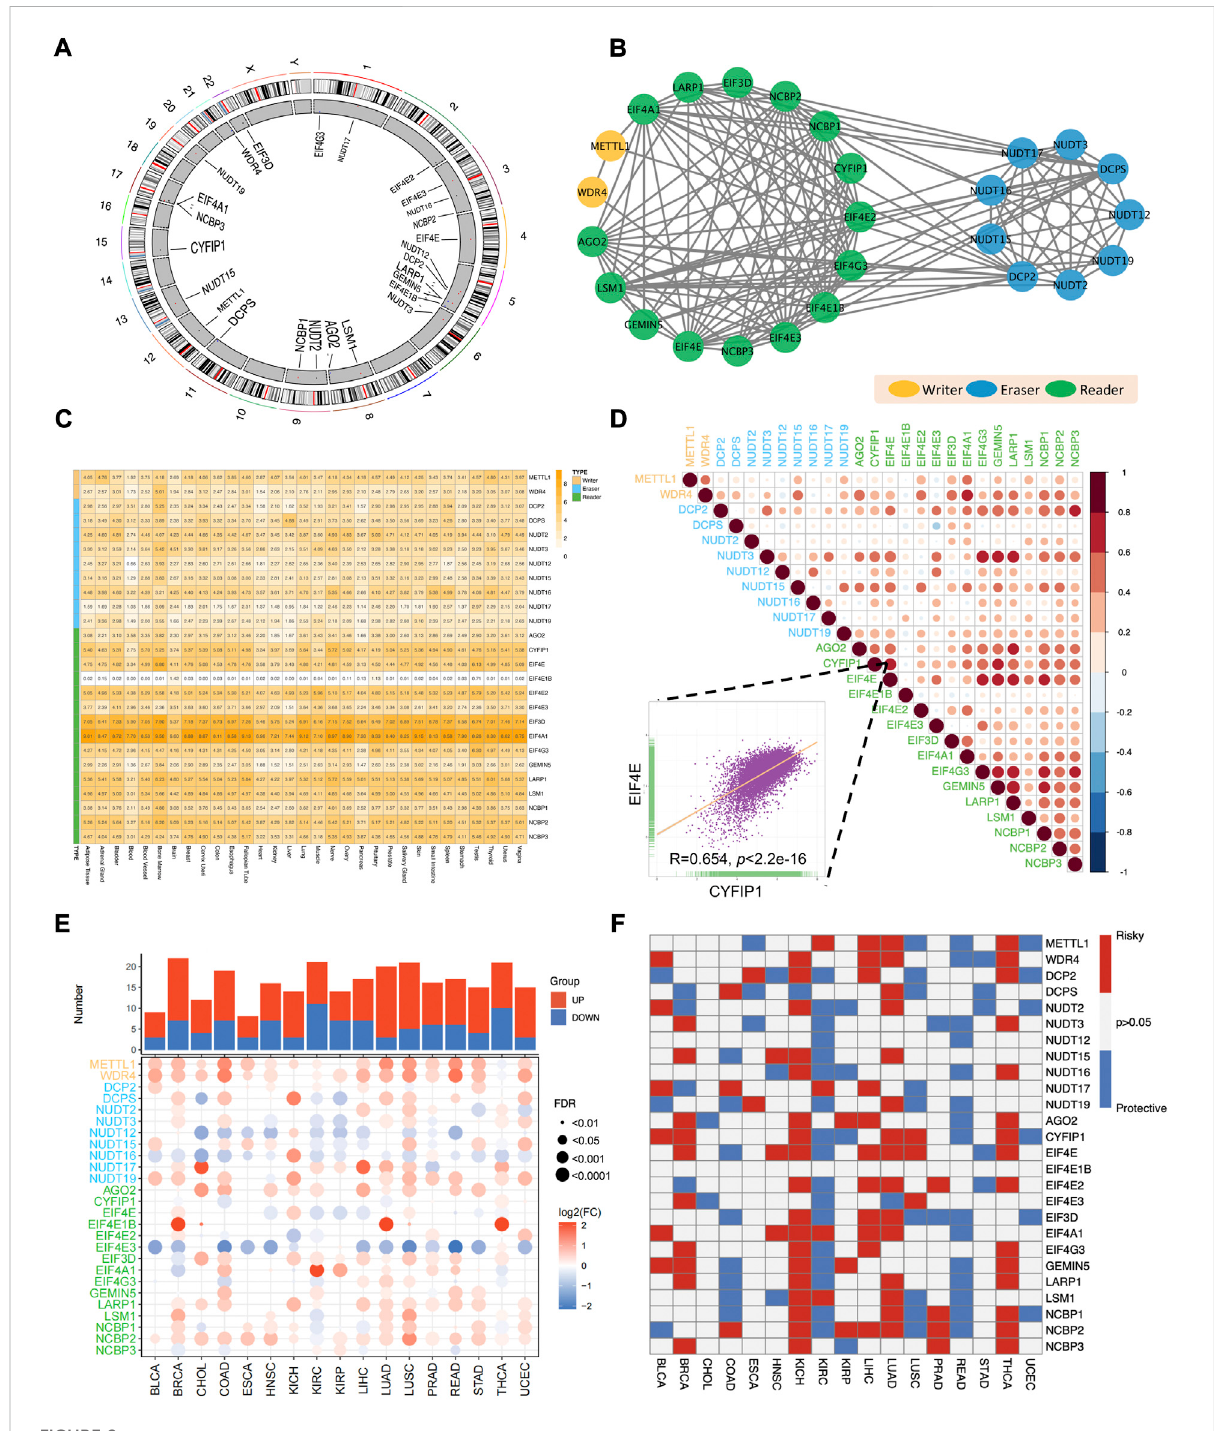
FIGURE 2 Aberrant expression and clinical relevance of m7G regulators across cancers. (A) The circular plot demonstrating the distribution of m7G regulators in human chromosomes. (B) The protein-protein interaction network among m7G regulators. (C) The expression pattern of m7G regulators among normal tissues in GTEx database. (D) The co-occurrence among m7G regulators. The scatter plot indicated the correlation betweenEIF4EandCYFIP1. (E) Thedifferentialexpressionofm7Gregulatorsbetweentumorandnormaltissuesacross17TCGAcancers. (F) The clinical relevance of m7G regulators among